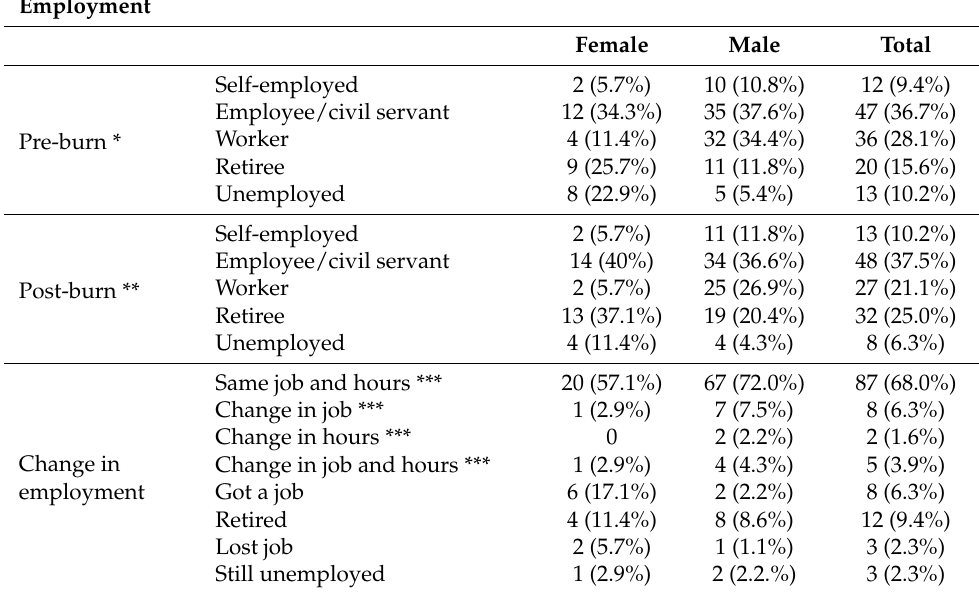
Table 5. Employment status of participants pre- and post-burn-injury.